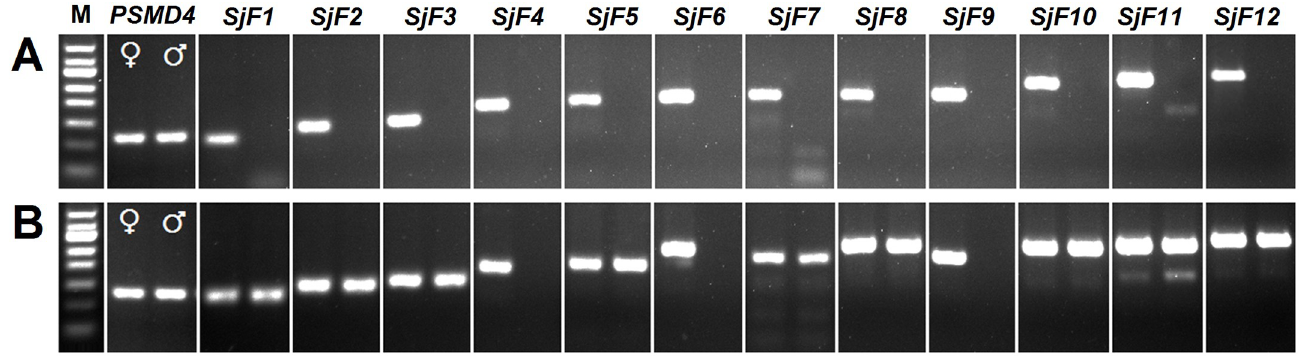
Fig 1. Identification of W chromosome-specific genes by end-point PCR. (A) End-point PCR using cDNA of adult females ( ♀ , left lanes) and cDNA of adult males ( ♂ , right lanes) as templates. (B) End-point PCR using genomic DNA of adult females ( ♀ , left lanes) and genomic DNA of adult males ( ♂ , right lanes) as templates. The expected sizes of PCR products are listed in Table 1. PSMD4 was selected as a reference gene (129 bp). M represents a 50-bp DNA ladder marker.